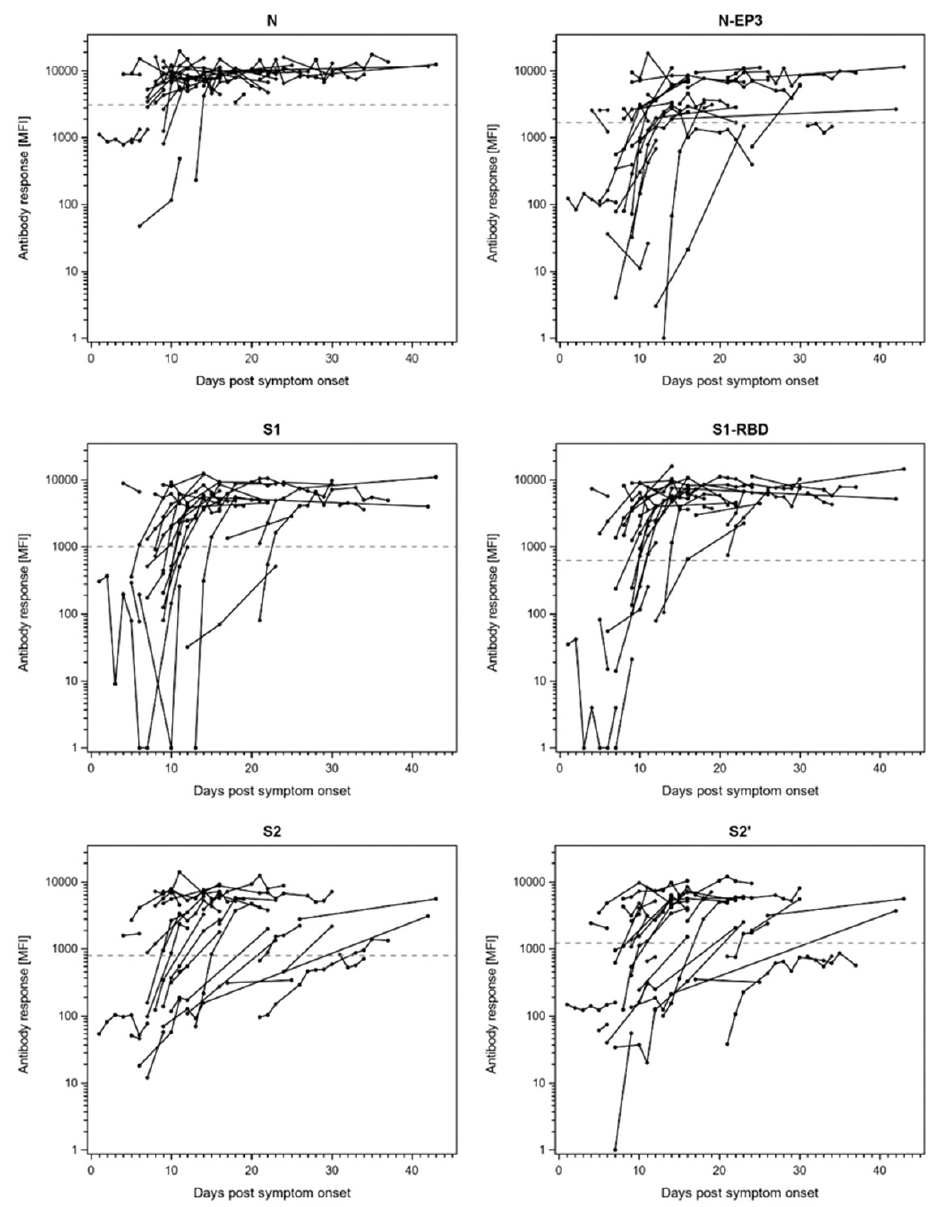
Figure 3. Antibody responses to SARS-CoV-2 proteins N, S1, S2, and their respective sub-fragments (N-EP3, S1-receptor-binding domain (RBD), and S2 (cid:48) ) in longitudinal samples of n = 32 hospitalized COVID-19 patients. The antibody response (MFI) is plotted against days post symptom onset. The dashed lines indicate the antigen-specific cut-offs defined as mean plus three times the standard deviation in n = 85 pre-pandemic